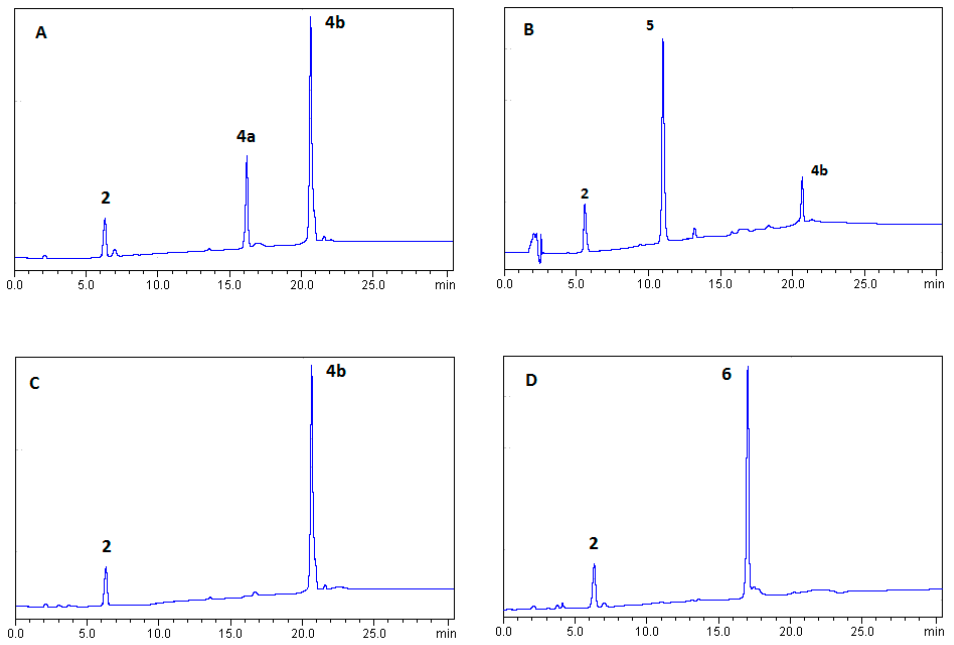
Figure 2. HPLC analysis of ( A ) the final mixture of 4a + 4b after 7 days reaction at rt of bis(2-aminophenyl) disulfide and palmitic acid in THF by using DIC as condensing agent; ( B ) during the reduction of 4a + 4b with NaBH 4 ; ( C ) after the reduction of 4a + 4b with NaBH 4 without subsequent acidification of the mixture; ( D ) after the reduction of 4a + 4b with NaBH 4 and subsequent acidification with AcOH; Column: LiChrospher ® 100 RP-18 (5 µ m) LiChroCART ® 250-4; Mobile phase: THF / H 2 O; Gradient: 50% THF to 100% THF in 30 min; Flow rate: 1mL / min; Detection at 254nm.